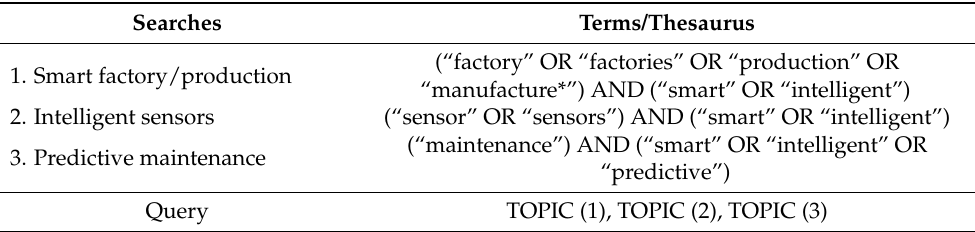
Table 2. Search strategy for burst detection analysis (1 December